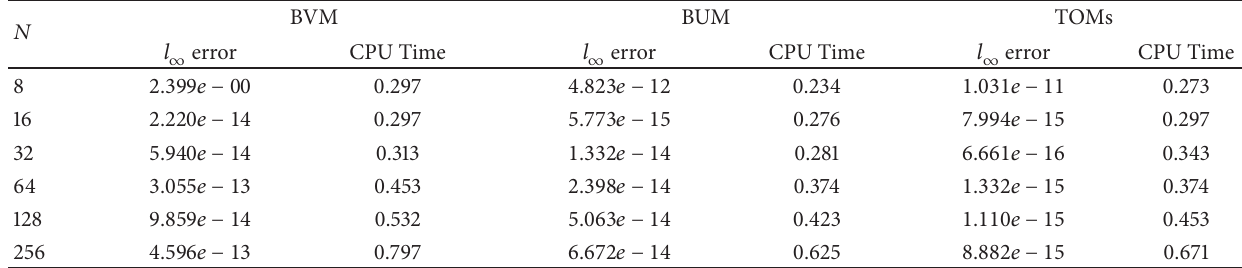
Table 6: Computational results for V = 4 for Example 5.3.